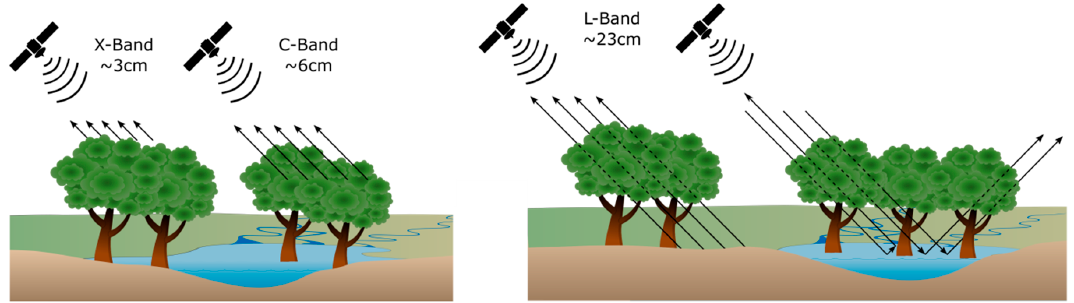
Figure 3. Radar backscattering mechanisms for di ff erent SAR wavelengths: X- and C-band (top) and L-band (bottom).